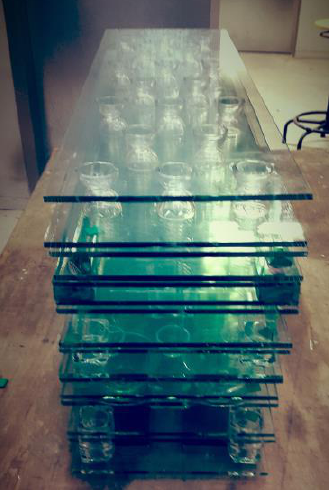
Fig. 1 stacked prototype